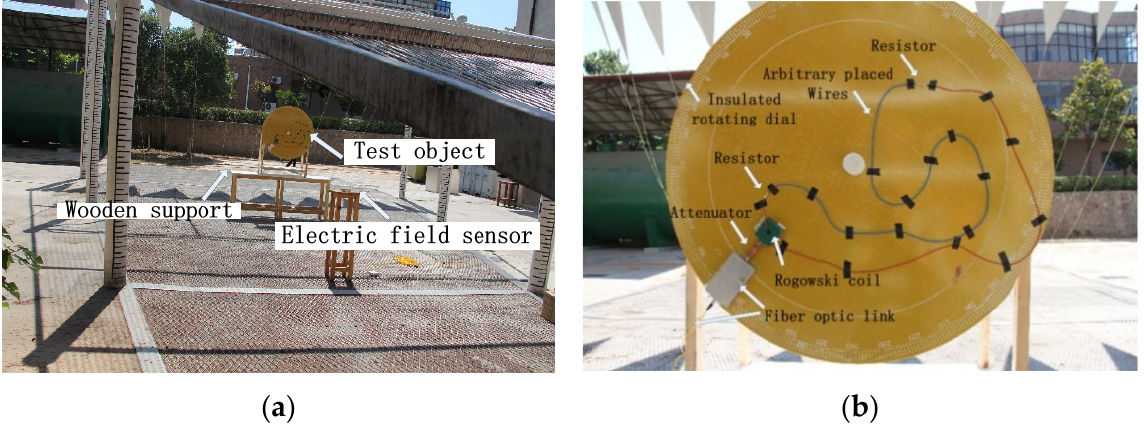
Figure 5. The layout of the cable coupling verification test: ( a ) macro scene of the test; ( b ) details of the object.